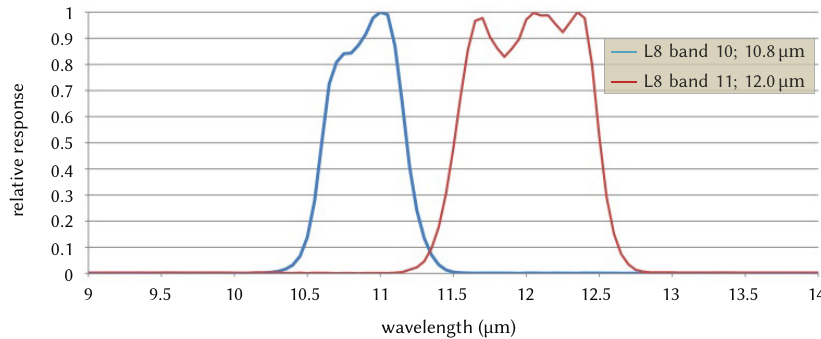
Figure 3. Effective wavelengths of Landsat 8 TIRS bands; 10.8µm for TIR band 10, and 12µm for TIR band 11. Source: Reference [59] (relabeled by the